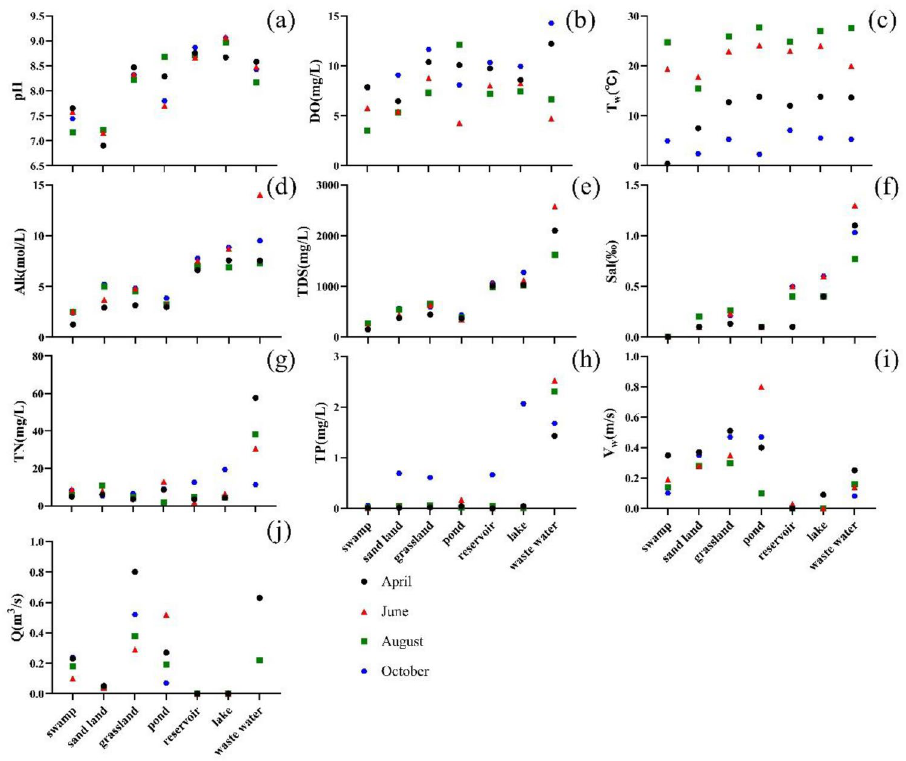
Figure 3. Box plot showing seasonal and spatial variation under different land use variations in six parameters of water quality(pH ( a ), DO ( b ), T w ( c ), Alk ( d ), TDS ( e ), Sal ( f ), TN ( g ), TP ( h ), V w ( i ), Q ( j